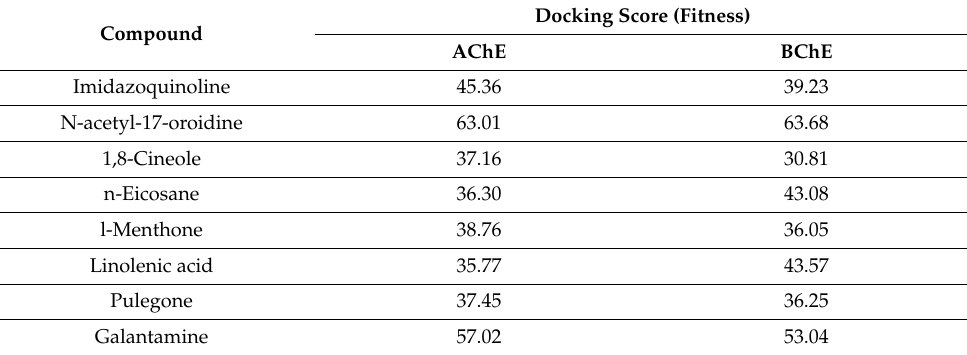
Table 2. Docking scores of galantamine and major compounds from Mentha piperita with both AChE and BChE.